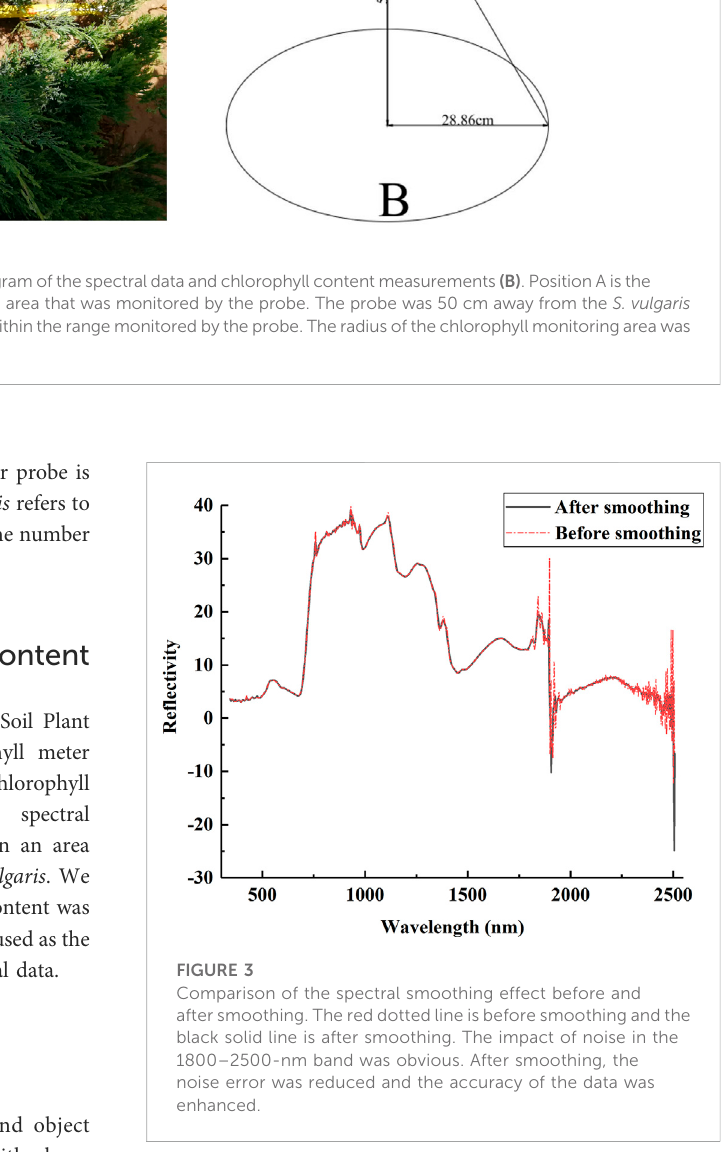
FIGURE 3 Comparison of the spectral smoothing effect before and after smoothing. The red dotted line isbefore smoothing and the black solid line is after smoothing. The impact of noise in the 1800 – 2500-nm band was obvious. After smoothing, the noise error was reduced and the accuracy of the data was